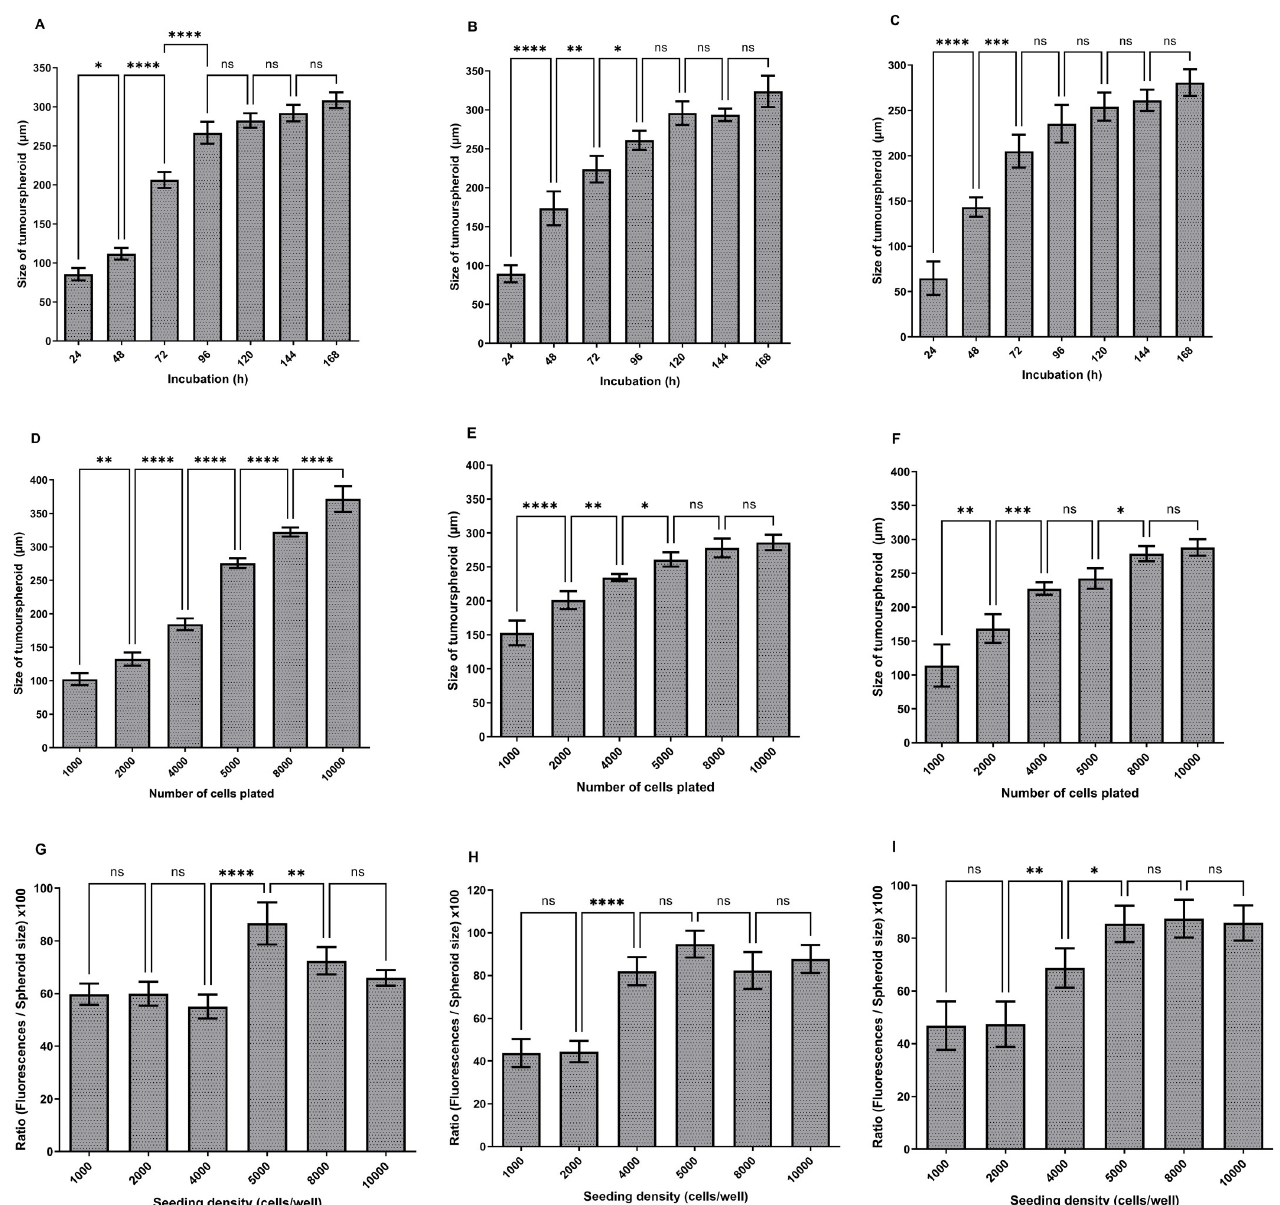
Fig 4. Development of U-251 MG human glioblastoma astrocytoma 3D in vitro cell culture model using hanging drop plate method. A) U-251 MG, B) U- 87 MG, C) A-172 tumourspheres growth (diameter in μ m) analysis during different incubations. D) U-251 MG E) U-87 MG, F) A-172 growth analysis after 96h incubation (diameter in μ m) at increasing seeding density. The mean of the diameter was used to plot the values on columns and analysed using one-way ANOVA with tukey’s post-test (ns, not significant (p > 0.05); � p < 0.05; �� p < 0.01, ��� p < 0.001; ���� p < 0.0001). G) U-251 MG H) U-87 MG, I) A-172 spheroid cell health analysed and a higher ratio indicates healthier spheroids. The mean of the [(fluorescence / spheroid size) x 100] was used to plot the values on columns and analysed using one-way ANOVA with tukey’s post-test (ns, not significant (p > 0.05); � p < 0.05; �� p < 0.01, ��� p < 0.001; ���� p < 0.0001).